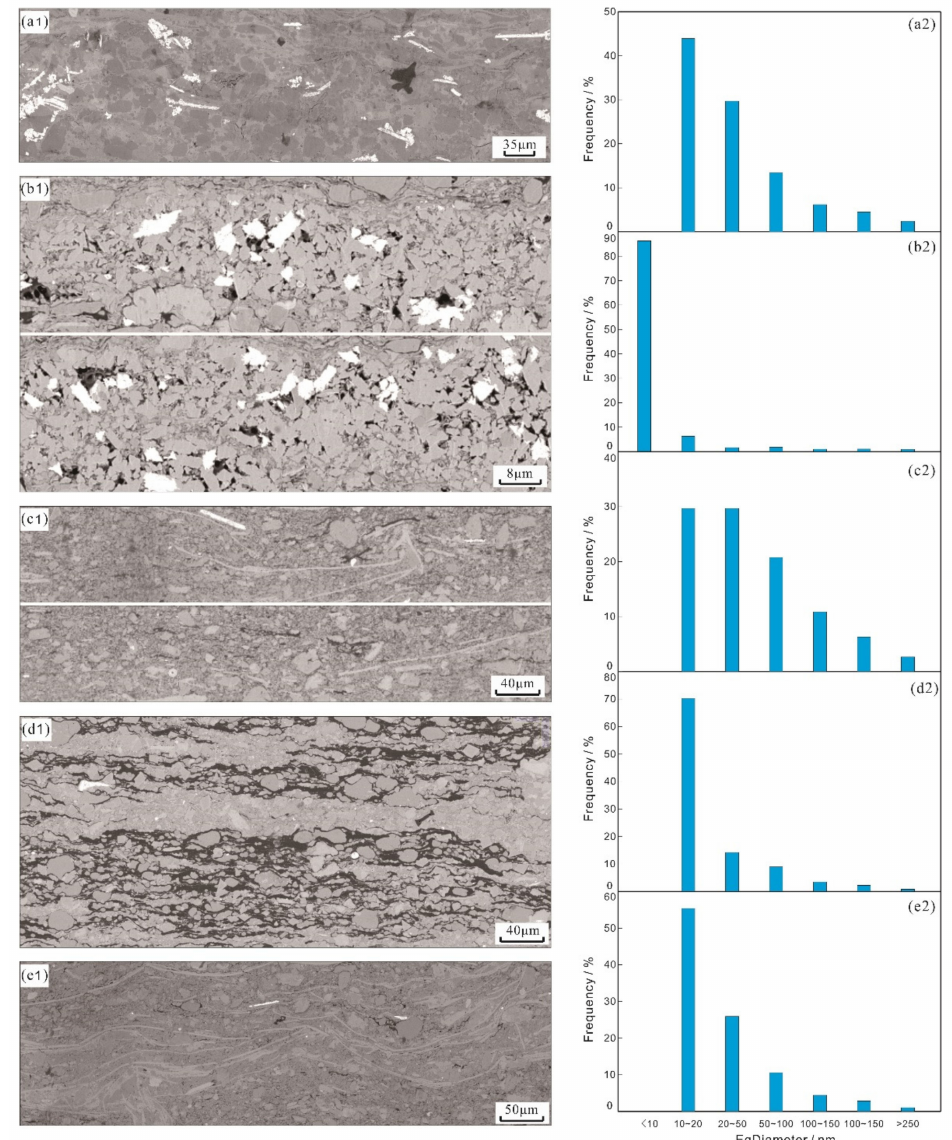
Figure 10. MAPS images and equivalent diameter of pores in different laminae. ( a1 , a2 ) MAPS images and equivalent diameter of pores in feldspar-quartz laminae; ( b1 , b2 ) MAPS images and equivalent diameter of pores in carbonate laminae; ( c1 , c2 ) MAPS images and equivalent diameter of pores in clay laminae; ( d1 , d2 ) MAPS images and equivalent diameter of pores in organic matter laminae; ( e1 , e2 ) MAPS images and equivalent diameter of pores in bioclastic